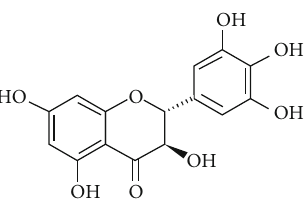
Figure 1: Chemical structure of dihydromyricetin